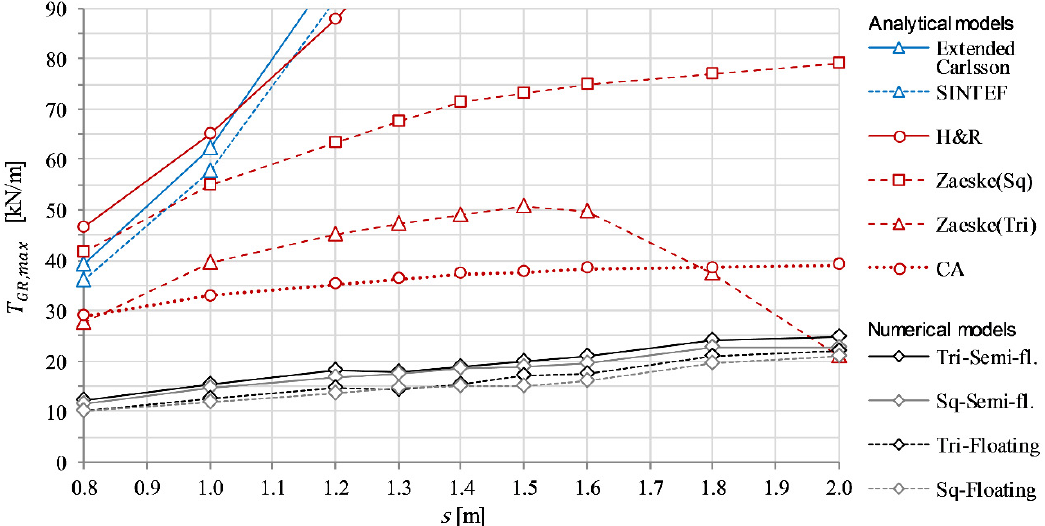
Figure 20. Comparison of the maximum tensile load in the GR ( T GR , max ) from the numerical and analytical results, plotted against s .